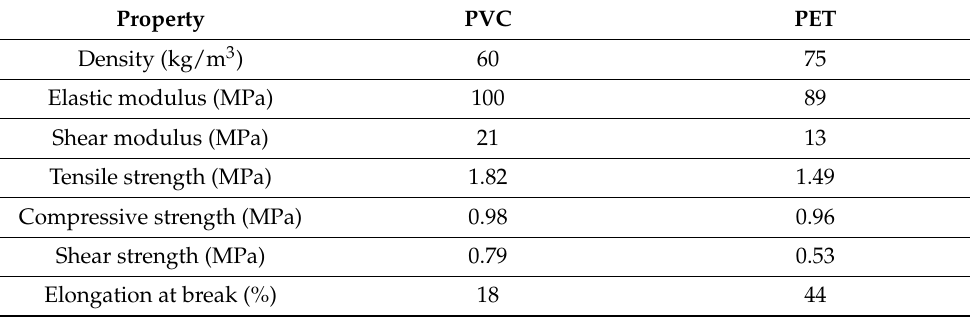
Table 2. Description of the properties of foam material being